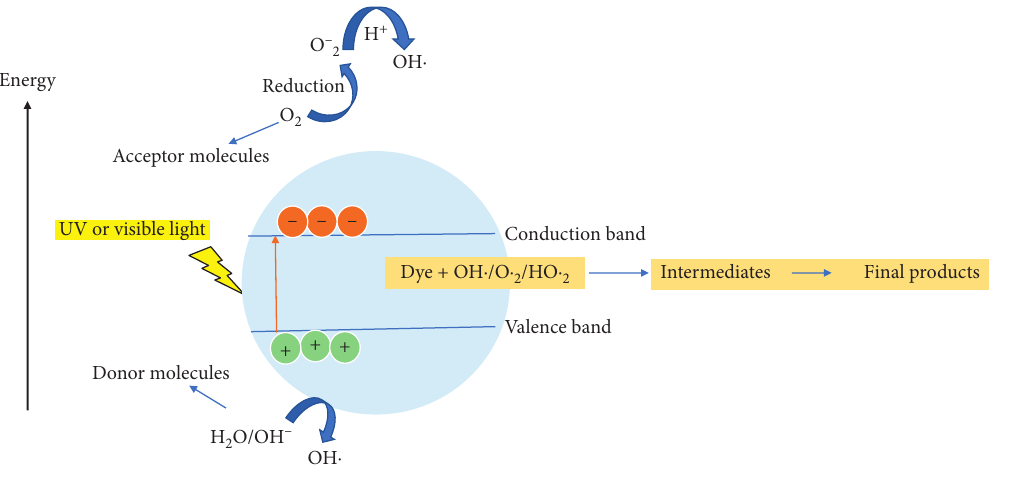
Figure 24: Mechanism of AgNPs photocatalysis